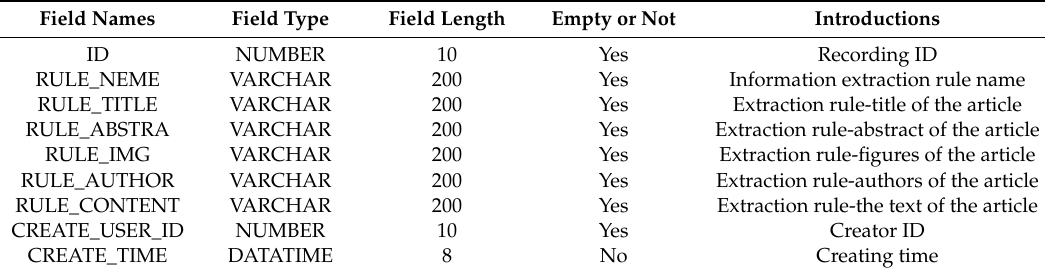
Table 1. Information Extraction Rule.